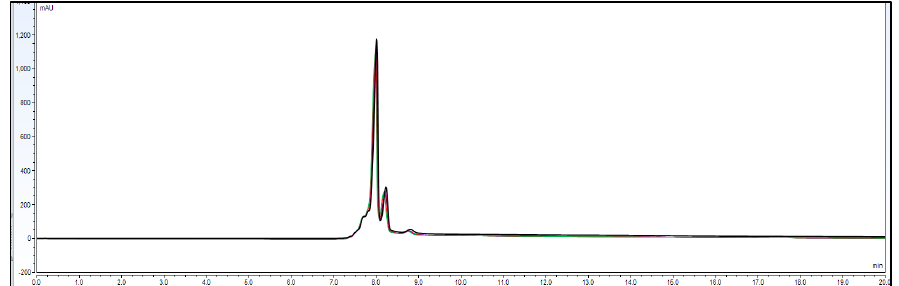
Figure 7. Chromatographic overlay for repeatability experiment using 6 different sample preparations of IgG1 sample 3.0 mg/mL concentration.